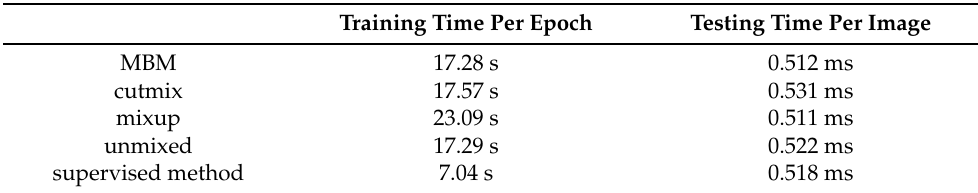
Table 6. Time analysis of the proposed method, cutmix, mixup, unmixed, and the supervised learning